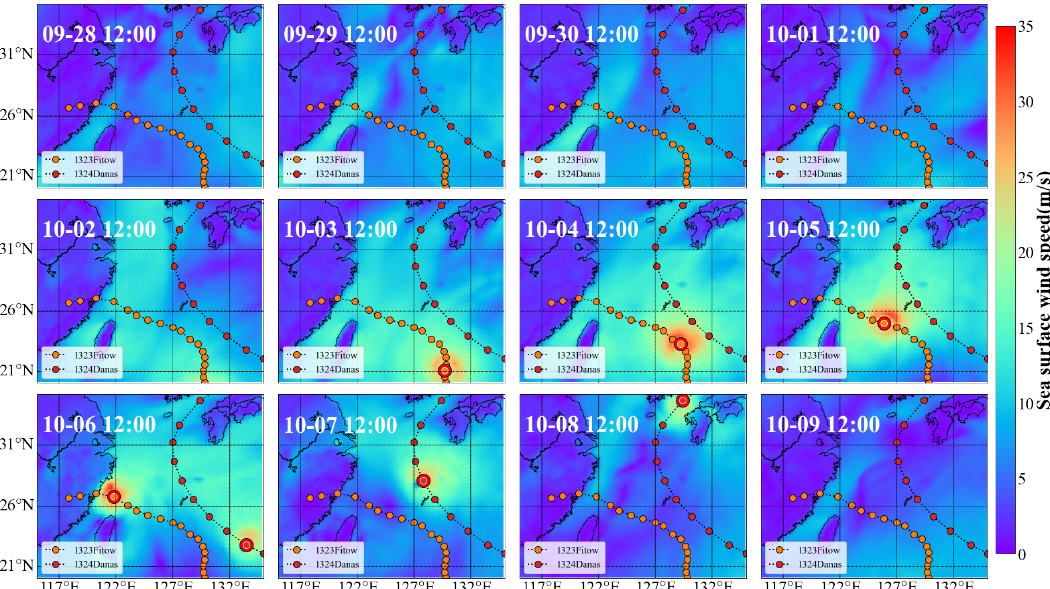
Figure 11. Time evolution of the daily sea surface wind speed from 28 September to 9 October during Typhoon 1323Fitow. The big circle in red is the location of the typhoon at 12:00 that